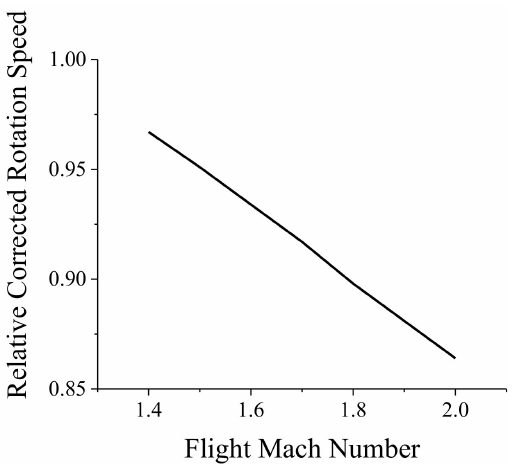
Figure 4. Relative Corrected Rotation Speed of AFS vs. Flight Mach Number.